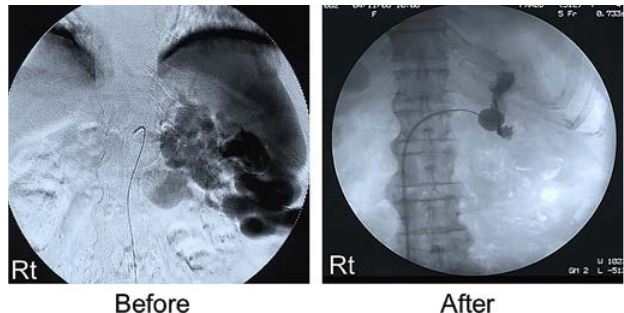
Figure 3 Angiography before and after balloon-occluded retrograde transvenous obliteration (B-RTO) in case 4. The abnormal vessel recognized before the treatment was not depicted by the embolization. Reprinted with permission of Ref.